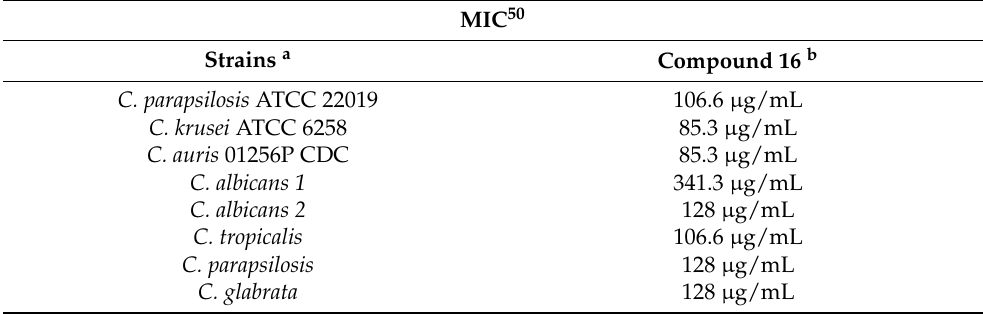
Table 2. Minimum inhibitory concentrations (MICs) of compound 16 against Candida spp.